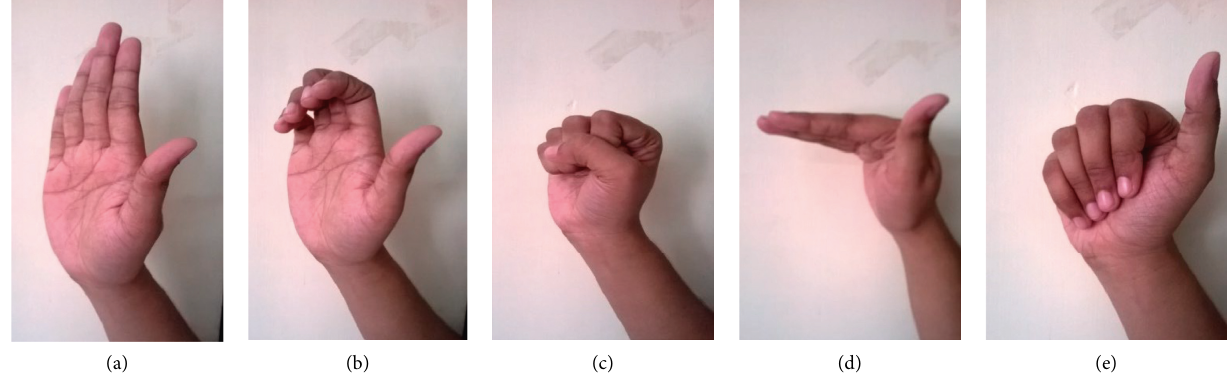
Figure 4: A supervised TGE ((a) straight; (b) hook; (c) fist; (d) table top; (e) straight